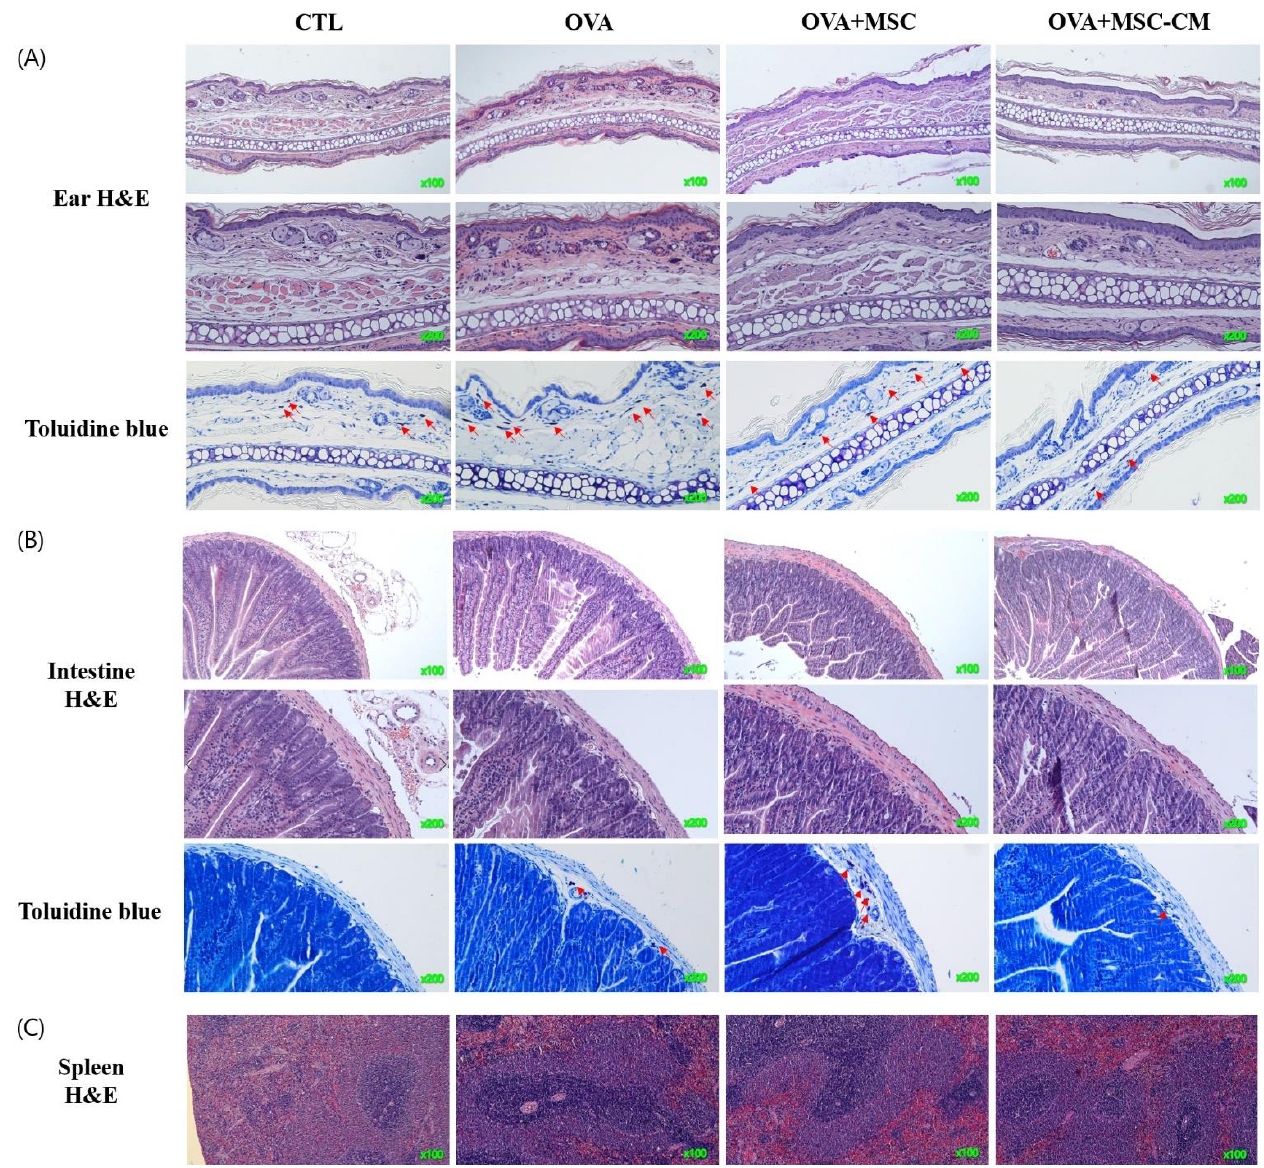
Figure 7. OVA challenge induced inflammation and mast cell infiltration in the tissue and MSC or MSC CM attenuated the change in the ear skin, SI, and spleen. Histological changes of ( A ) ear skin, ( B ) SI, or ( C ) spleen are shown. Sections are stained with H&E (hematoxylin and eosin, ear skin × 100, × 200, SI, × 100, × 200, spleen × 100) or Toluidine blue ( × 200). Mast cells are indicated by red arrows. H&E, hematoxylin, and eosin; MSC, mesenchymal stem cell; MSC CM, mesenchymal stem cell culture medium; OVA, Ovalbumin; SI, small intestine.